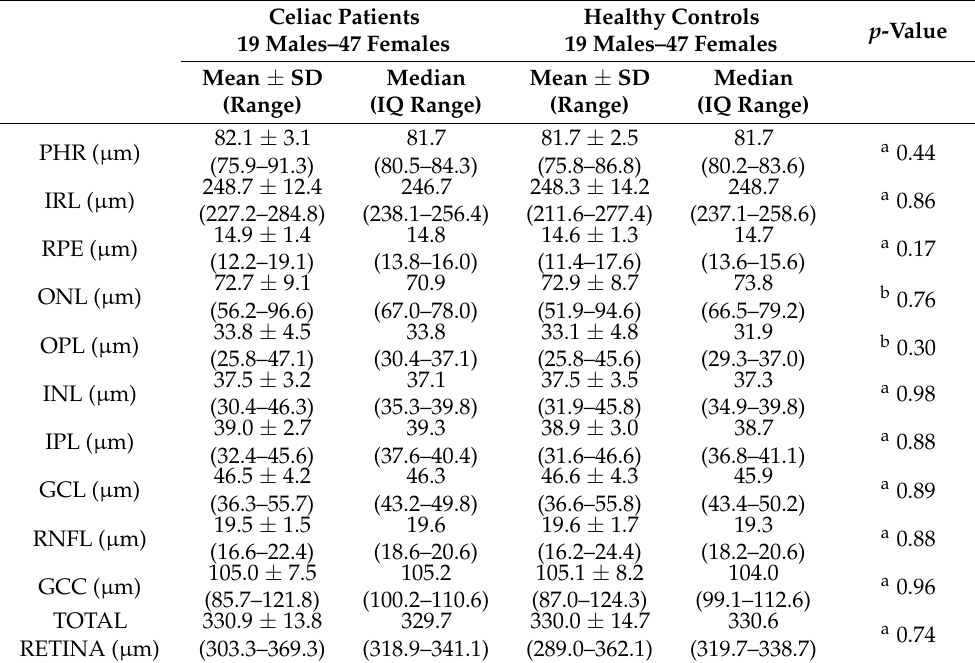
Table 3. Comparison of average retinal layer thicknesses ( µ m) between celiac patients and healthy subjects at 3 mm diameter of ETDRS grid on OCT.